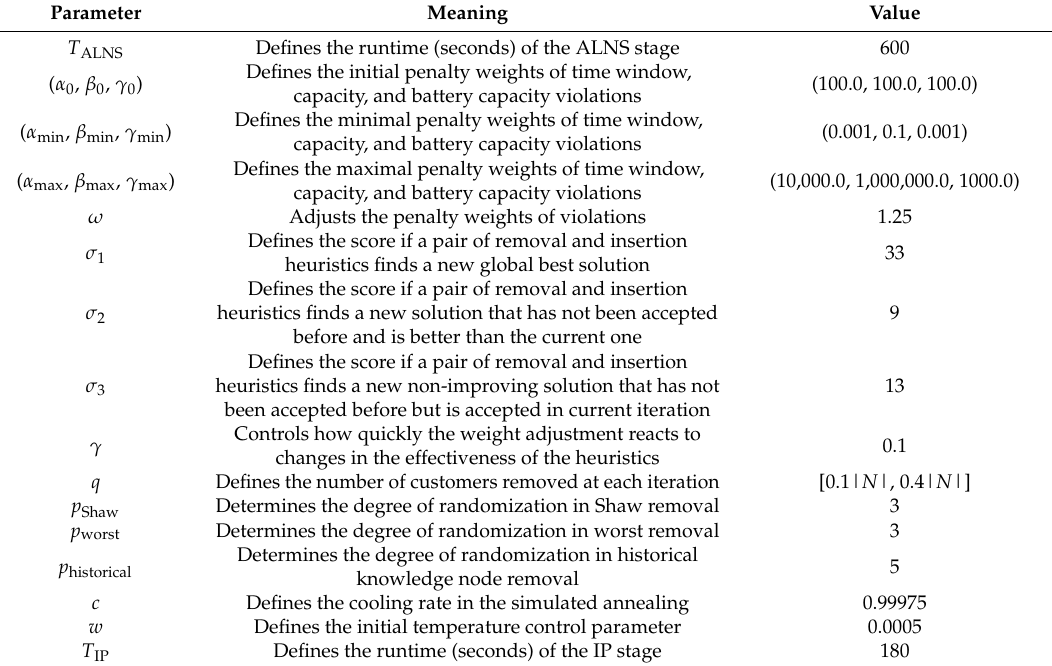
Table 2. Values for the parameters of the proposed algorithm after the tuning phase.